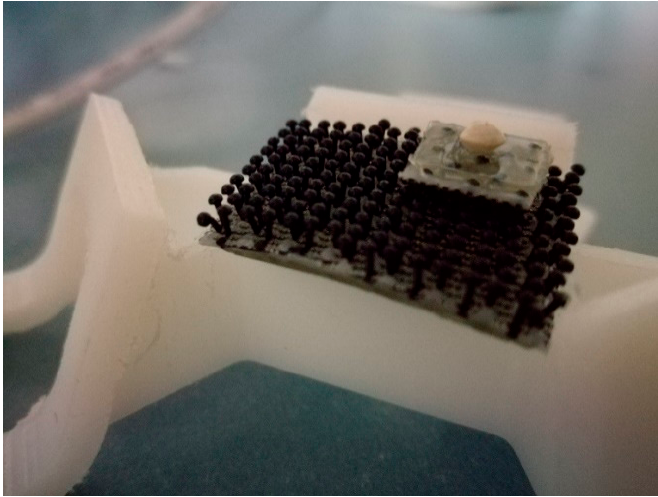
Figure 6. One specimen of P. casertanum installed on the support of SmartShell.